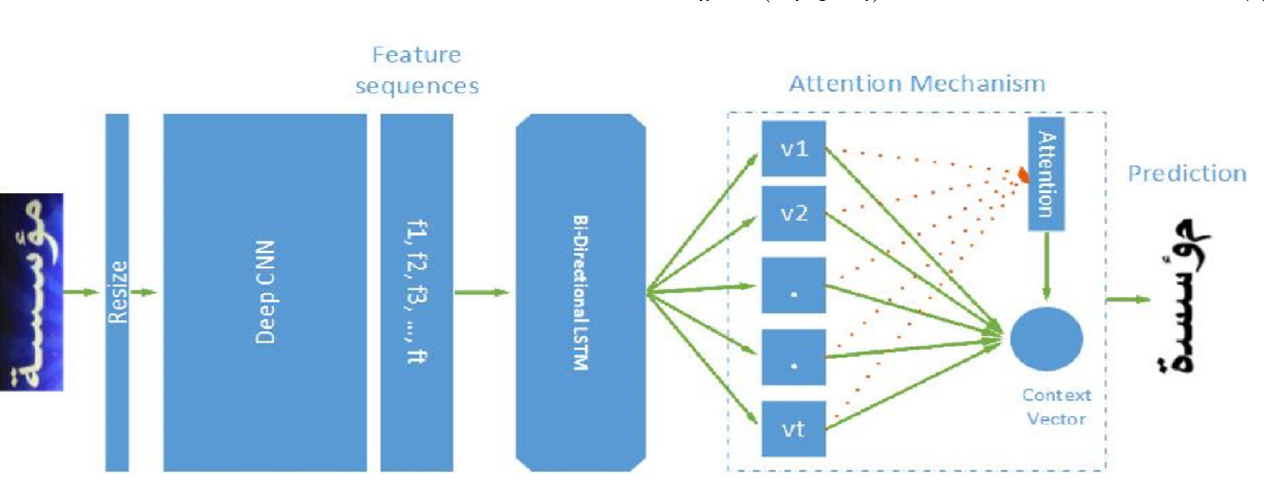
Table 1. Statistical detail of ACTIV